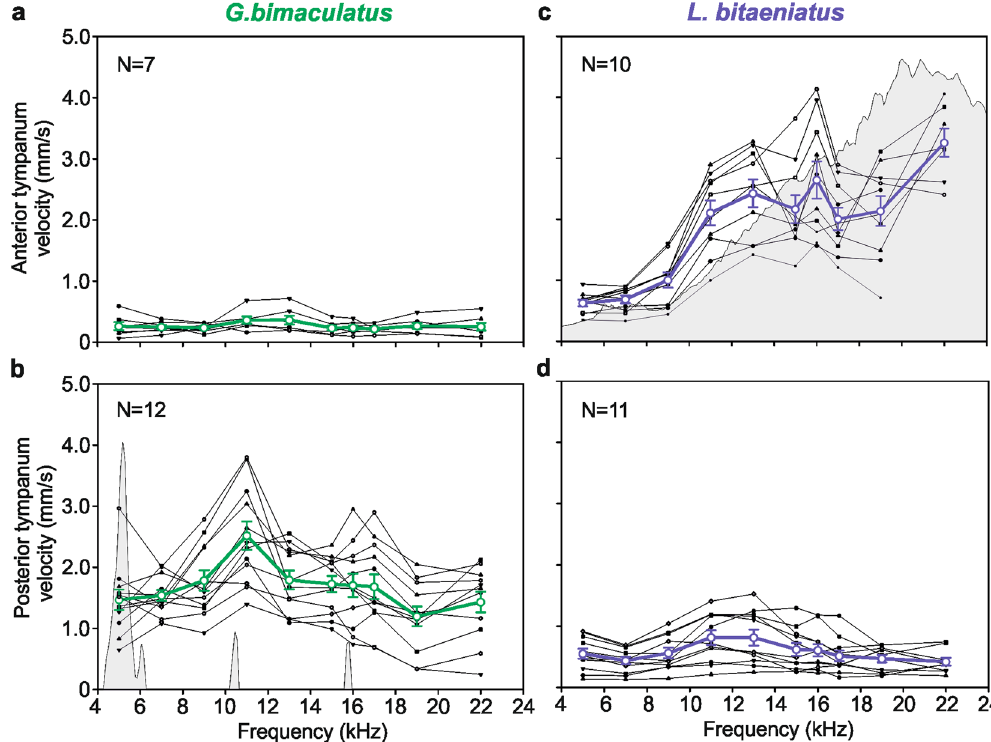
Figure 5. For the field cricket G . bimaculatus and the Eneopterinae species L . bitaeniatus , Laser Doppler vibrometry was used to determine the vibration velocities of the anterior ( a and c ) and posterior tympanum ( b and d ). Individual sensitivity tuning curves are shown as thin black lines and the respective mean curves ( ± standard error of mean) are shown as coloured, thick lines. The power spectrum (given in relative amplitude) of a typical male’s call are shown in the background of the subfigures ( b ) and ( c ).